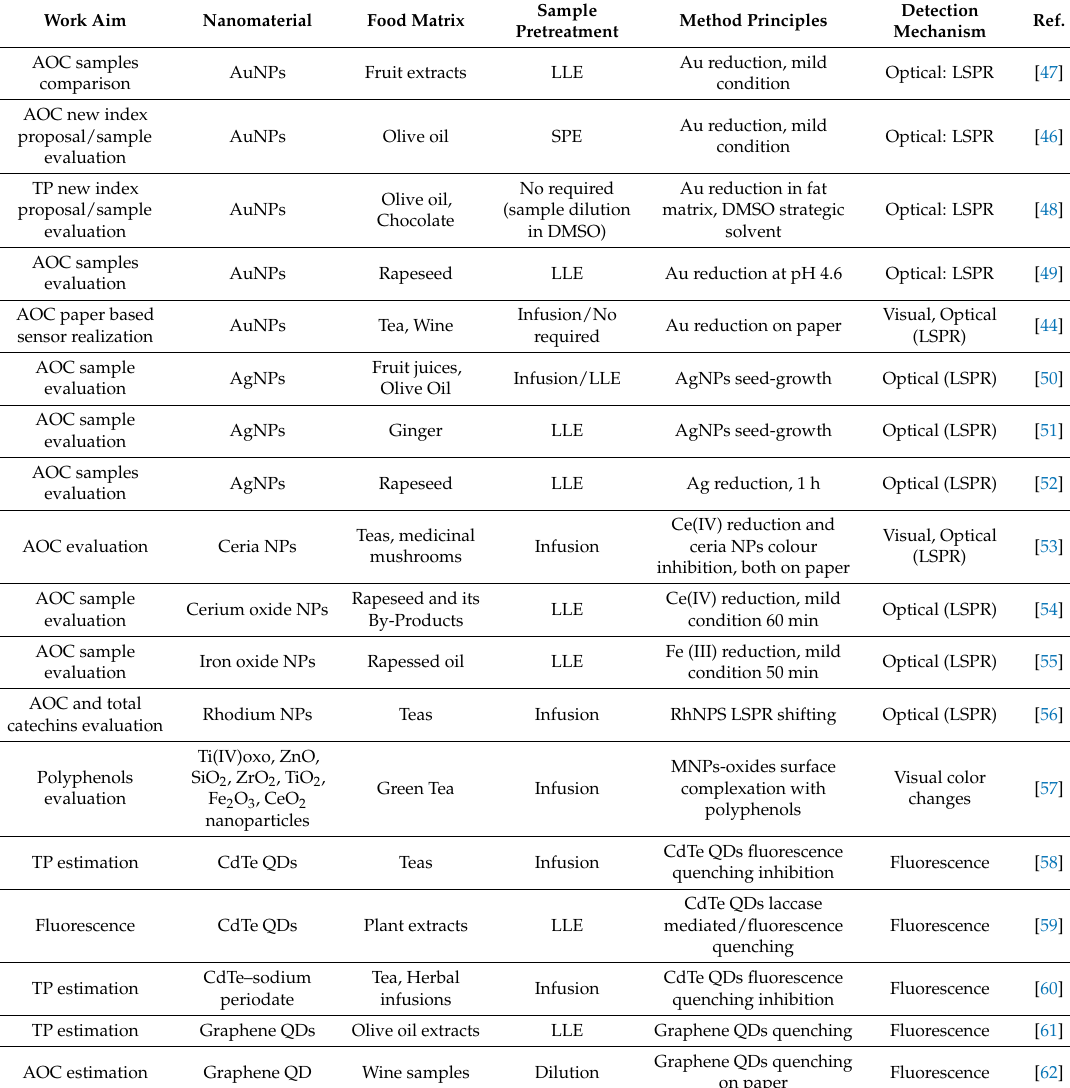
Figure 1. Schematic representation of AuNPs formation mediated by polyphenols. Colorimetric formation curve (caffeic acid) obtained following the Della Pelle et al. [46] strategy. Table 1. Main strategies and features of optical nanomaterial-based assays for food polyphenols evaluation.